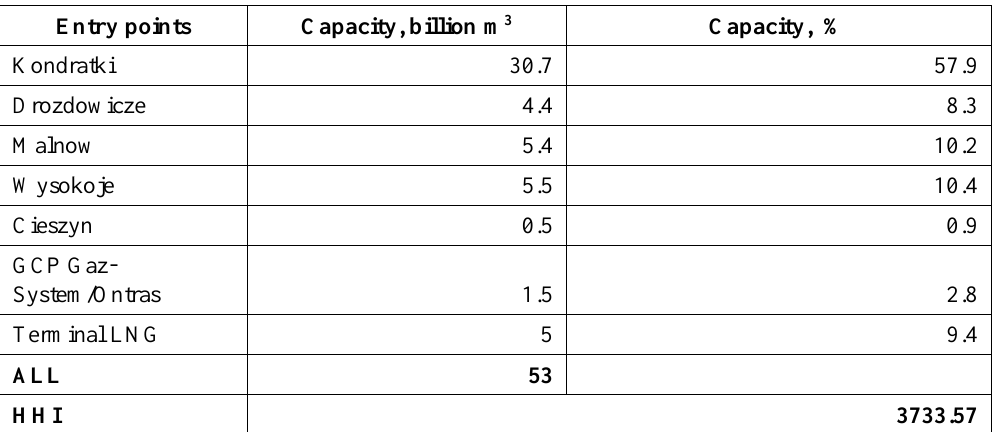
Table 2. Capacity for Natural Gas Import in Perspective in 2016, in Billion m 3 (developed by the author, based on GAZ-SYSTEM, 2016, p. 9; 20; URE, 2018,